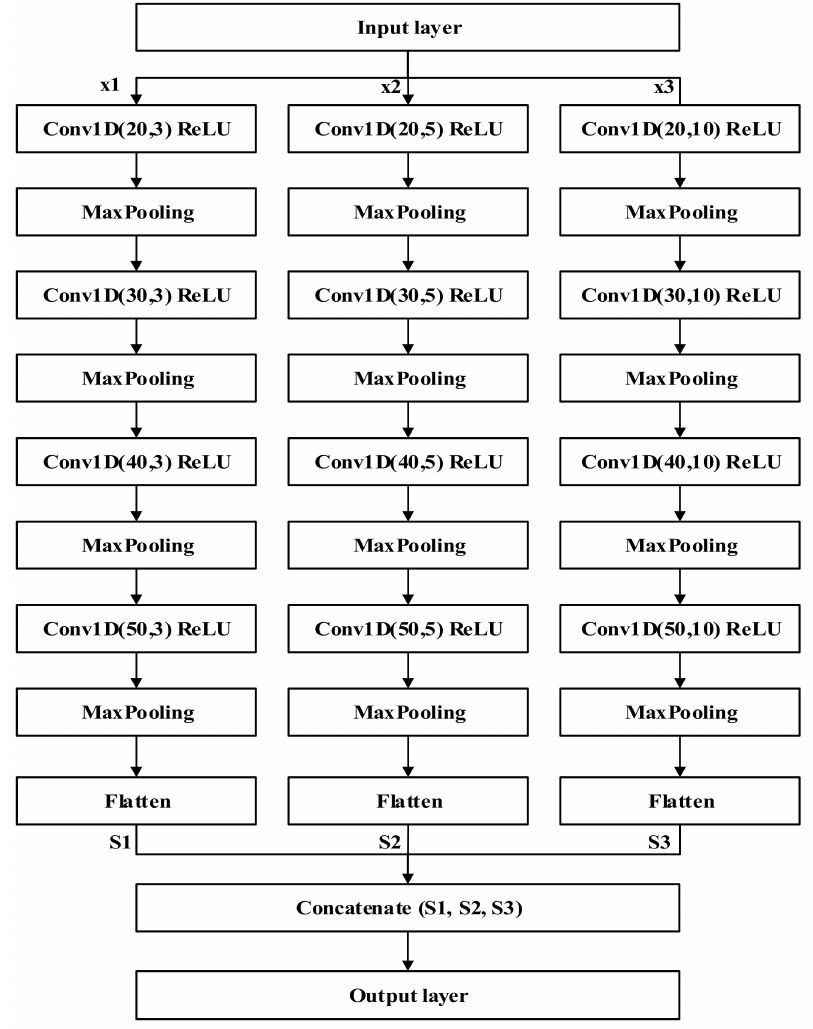
Figure 5. Detailed Framework of The Multi-kernel